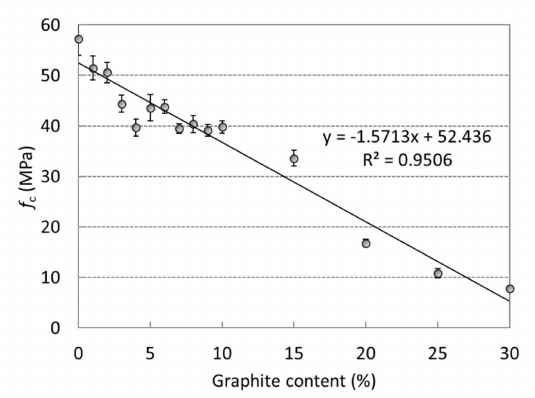
Figure 3. Compressive strengths of alkali-activated slag (AAS) composites with 0 wt%–30 wt% of graphite powder (standard deviations are presented as error bars).